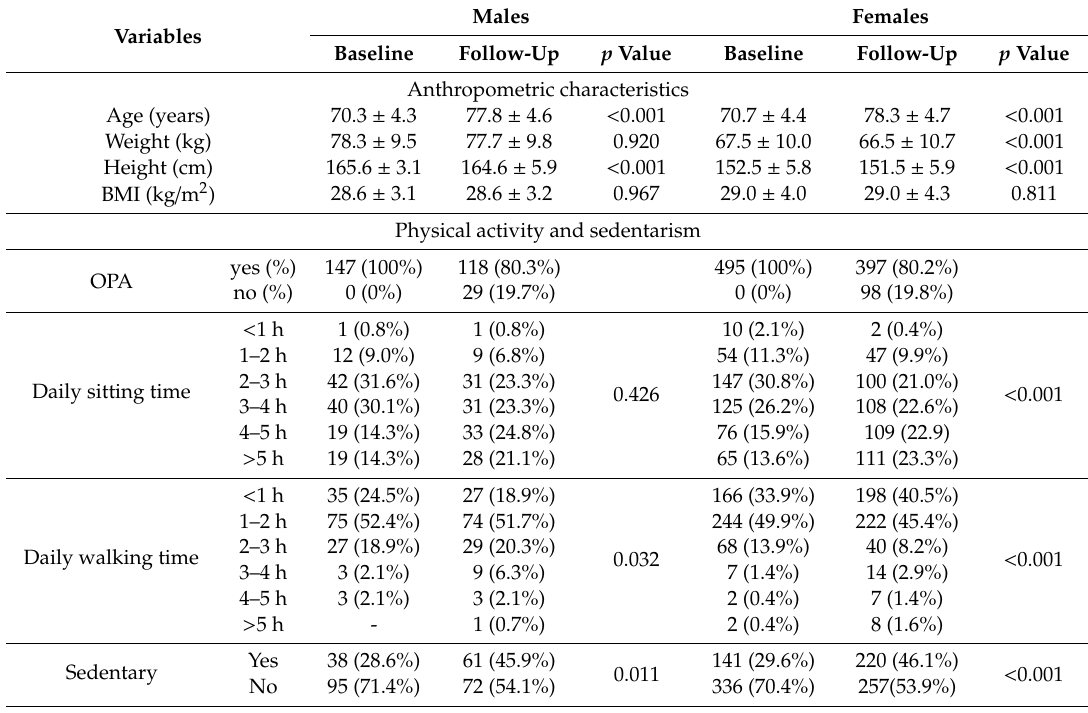
Table 1. Descriptive characteristics of the participants divided by sex for both the baseline and follow-up